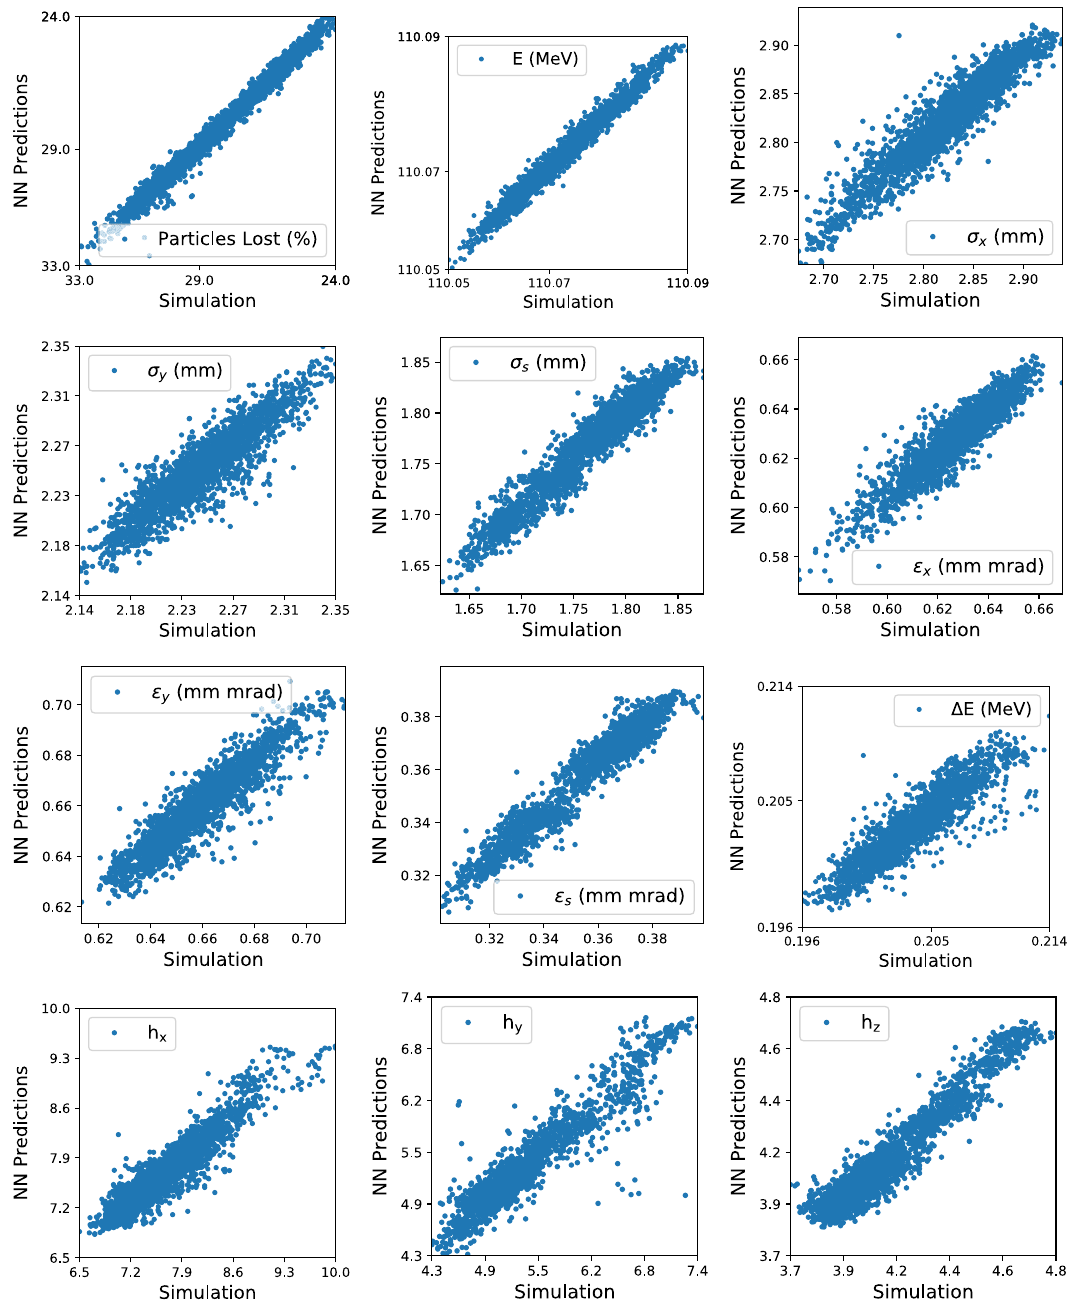
FIG. 14. Example predictions from IsoDAR model trained on 12 outputs vs true values. Perfect prediction would correspond to a straight diagonal